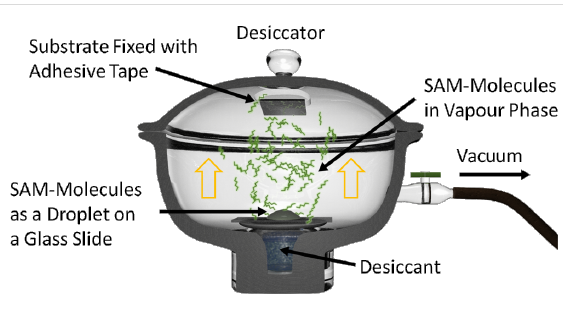
Figure 2: Preparation of a densely packed SAM, performed in the vapor phase within a desiccator.